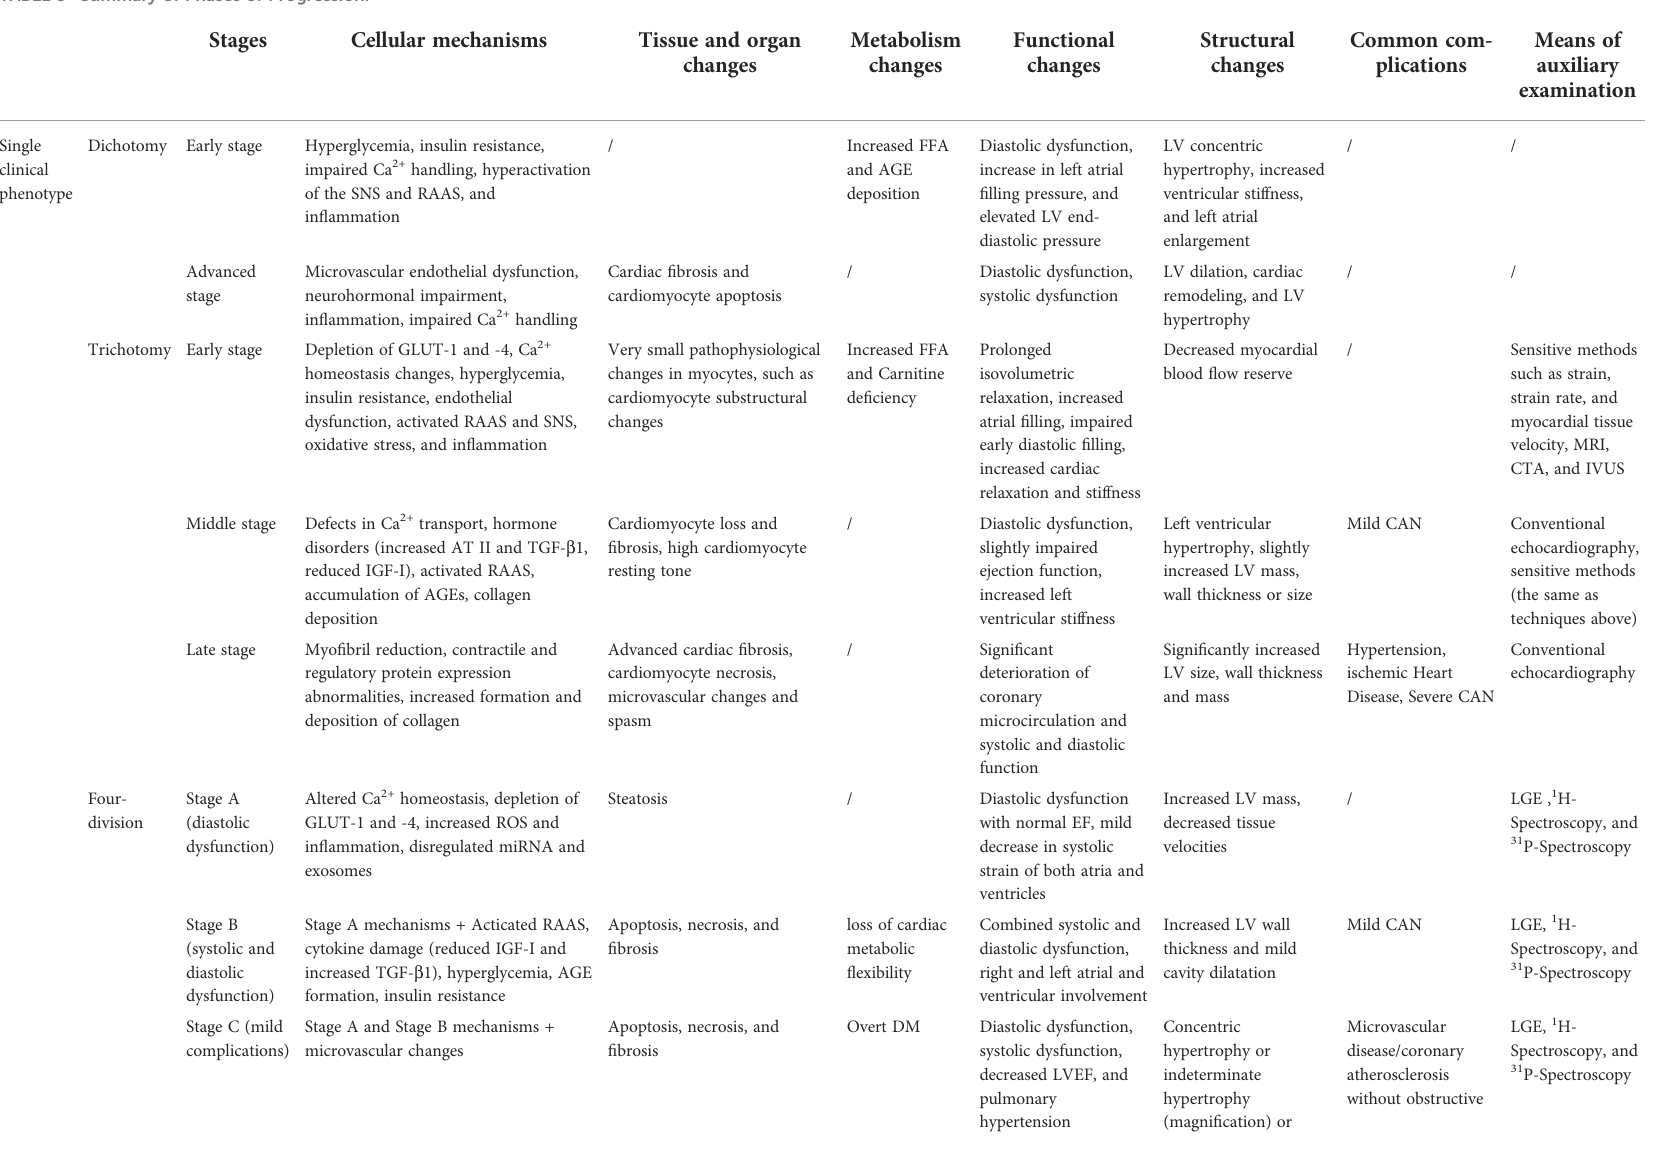
TABLE 5 Summary of Phases of